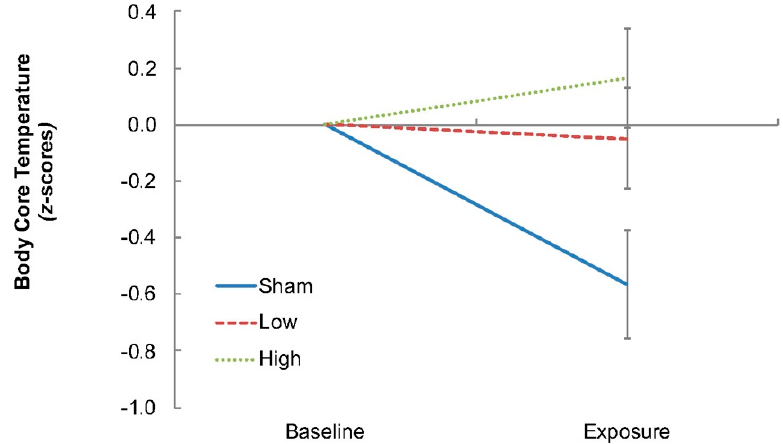
Figure 1. Body core temperatures across exposure conditions, as measured from the auditory canal. As shown here, temperature increased immediately in both exposure conditions relative to the Sham condition (exposure measurement corresponds to the average of the first 4 min of exposure), which due to thermal inertia is too early to represent a real change in body core temperature. Furthermore, this change does not reflect the lack of body core temperature change due to much larger whole body radiofrequency exposures [24], nor the longer (22–34 min) body core thermal time constants modelled using radiofrequency exposure conditions more conducive to body core temperature elevation (e.g., [25]).